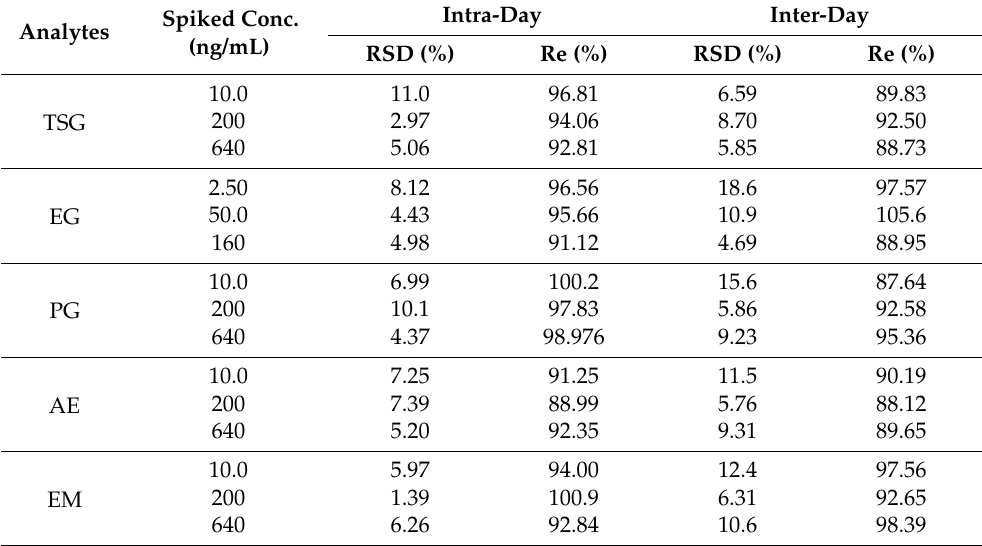
Table 1. The results of linear ranges, regression equations, and LLOQs of five detected compounds. Table 2. Precision and accuracy of the method for the determination of TSG, EG, PG, AE, and EM in rat plasma ( n =